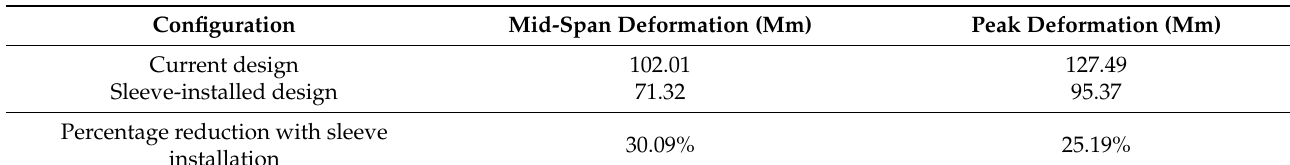
Table 5. Deformation results of both composite cross-arm configurations [66].